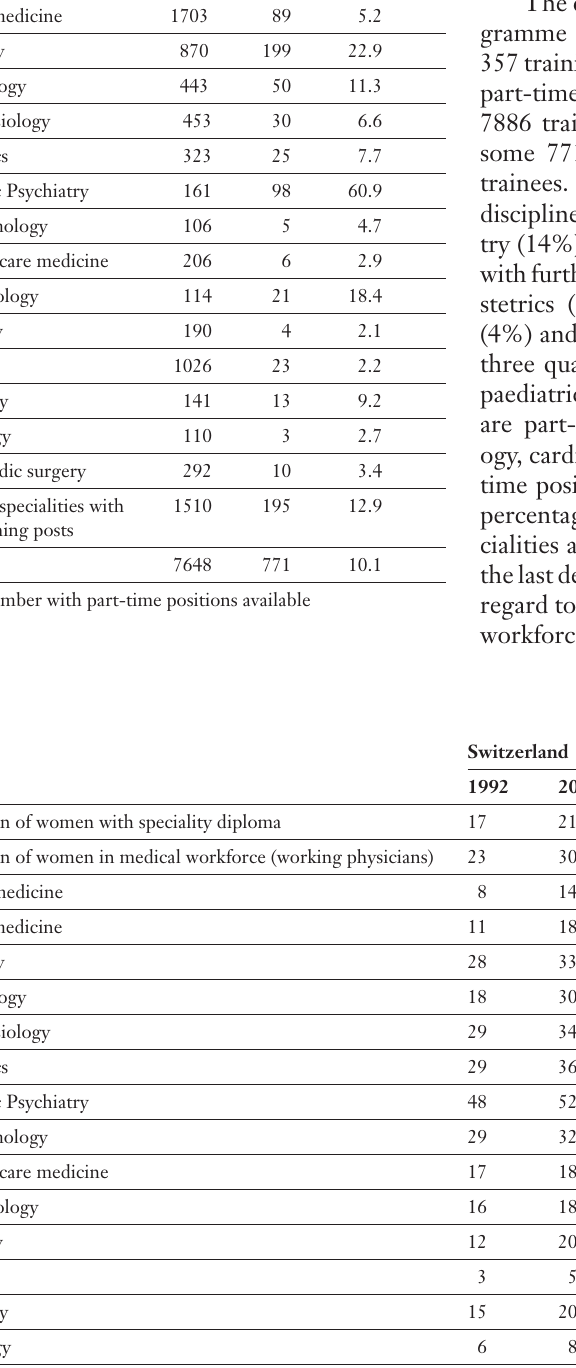
Table 2 Availability of train- ing positions and their proportion ac- cording to speciali- ties. Values are num- bers (percentages).